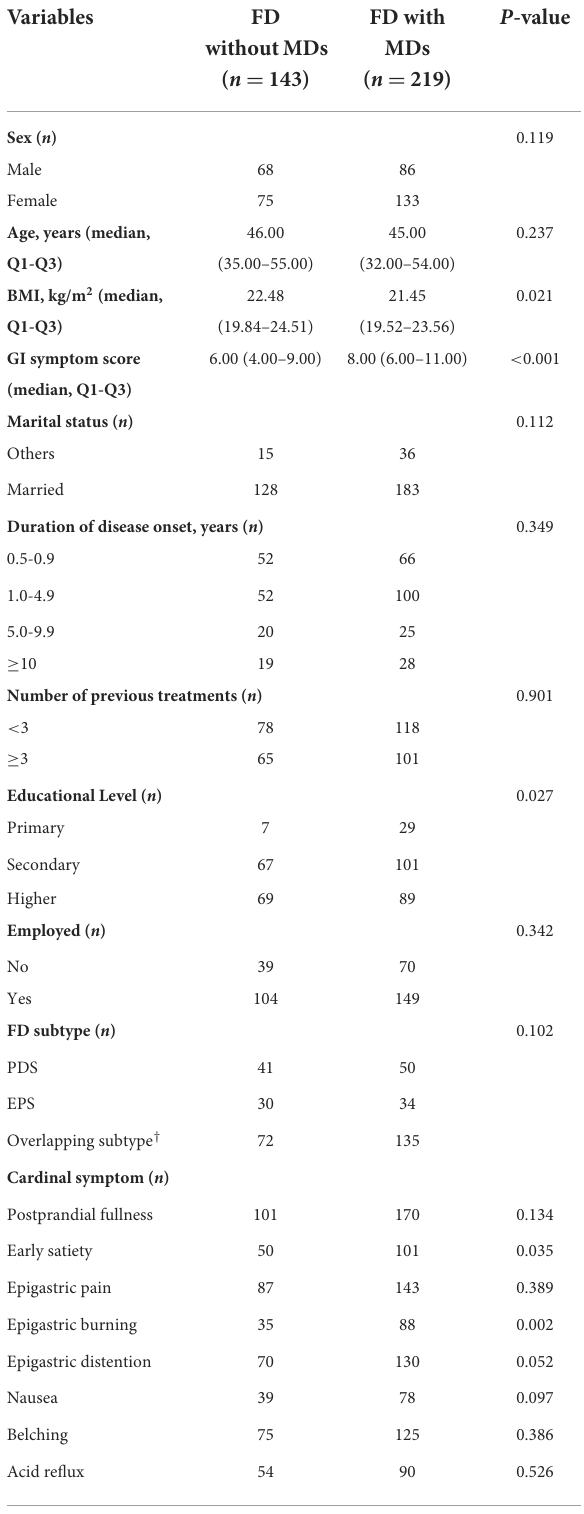
TABLE 1 Univariate analysis of risk factors for mood disorders in patients with functional